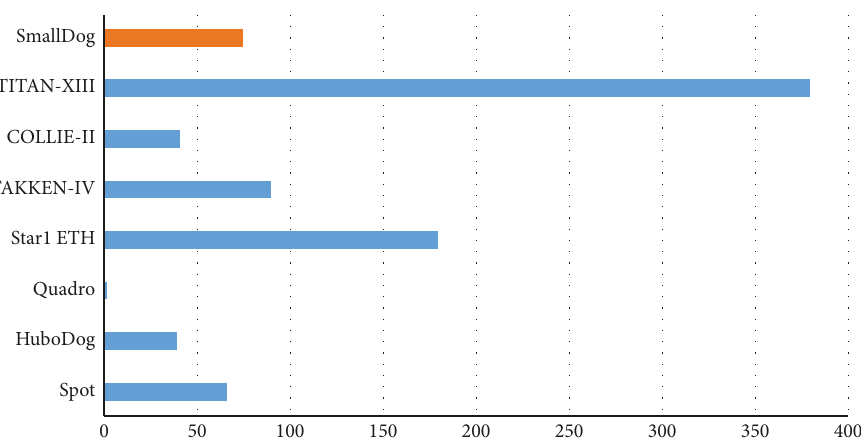
Figure 19: Normalized work